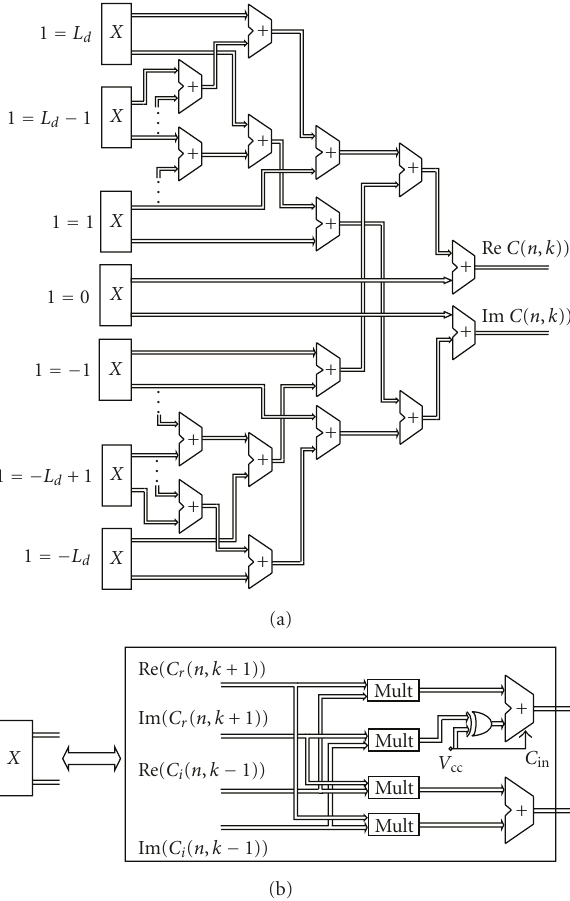
Figure 8: Architecture for realization of (a) C ( n , k ) and